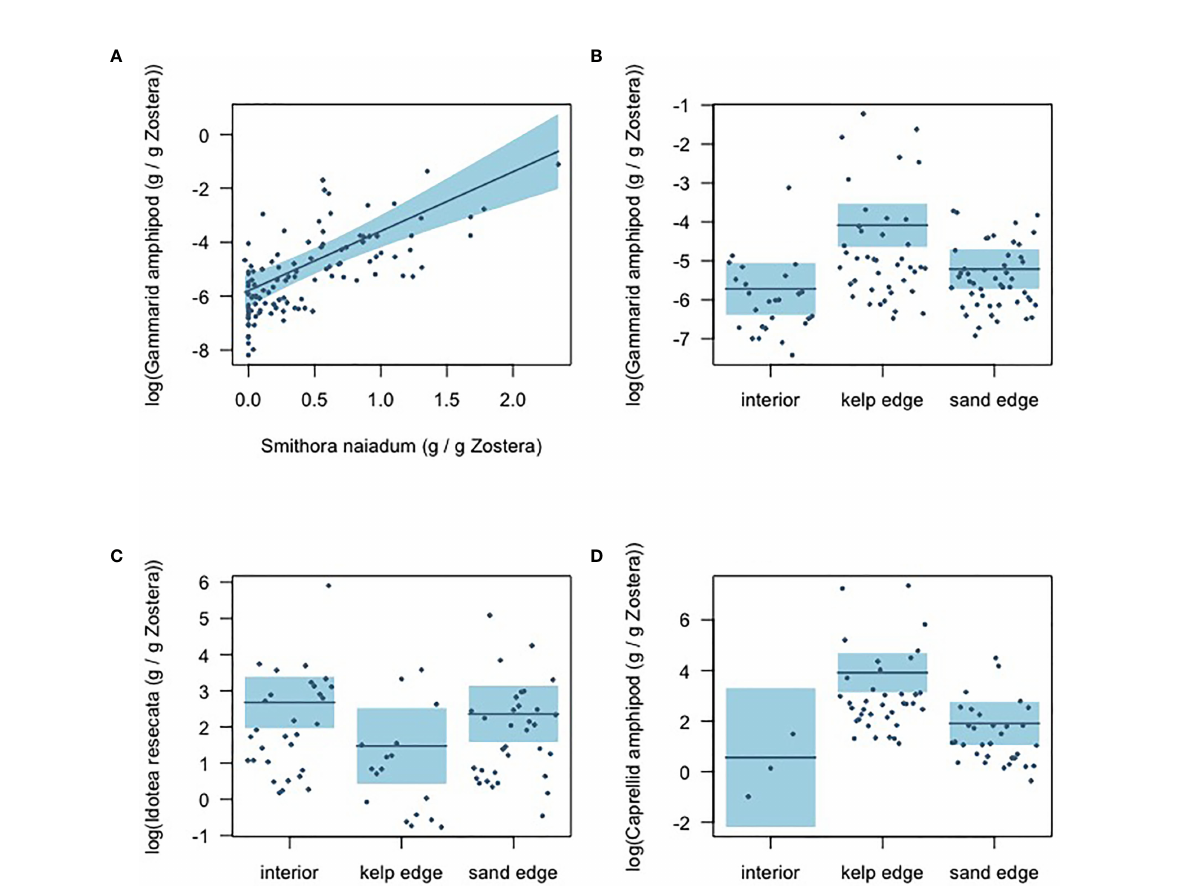
FIGURE 5 Gamma-hurdle model results showing the (A) relationship between S. naiadum epiphyte biomass and gammarid amphipod biomass (standardized by Z. marina biomass); and the mesograzer biomass distributions across the meadow sites: (B) gammarid amphipods (C) I. resecata , and (D) caprellid amphipods. Shaded blue indicates 95% con fi dence